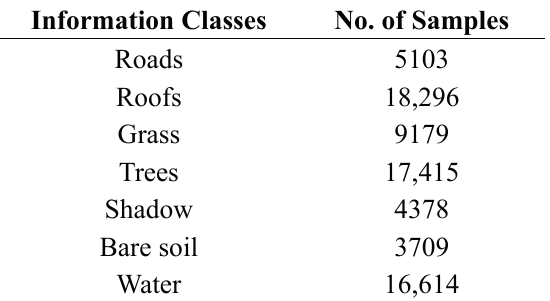
Table 6. The numbers of samples in the reference data for the QuickBird Wuhan